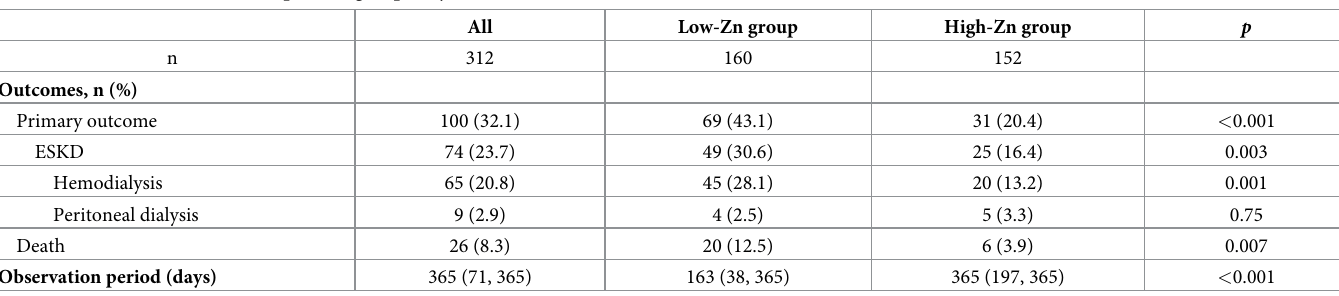
Table 2. Incidence of outcomes in patients grouped by Zn